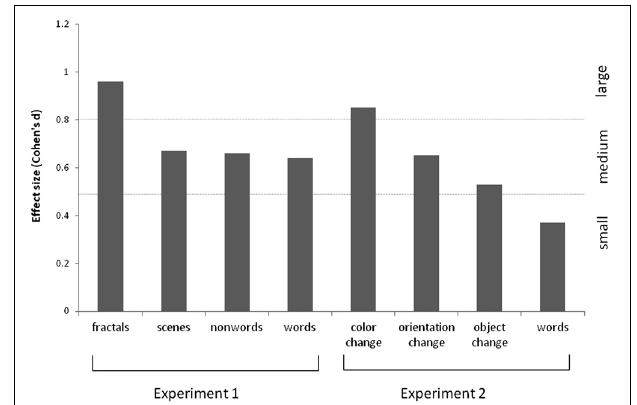
FIGURE 3 | Effect sizes (Cohen’s d) for the various stimuli used in Experiments 1 and 2, for grapheme-color synaesthetes relative to controls. These are calculated based on the memory discriminability estimates (i.e., d-prime, normalized hits minus false alarms).